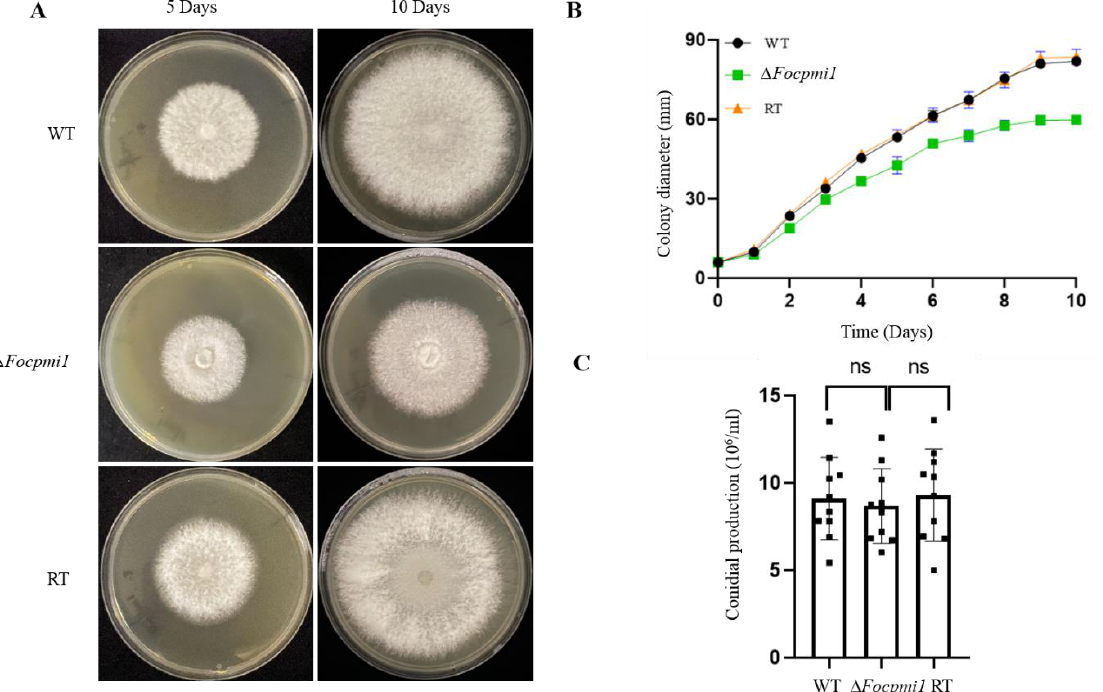
Figure 3. Vegetative growth of the WT, ∆ Focpmi1 , and RT strains on YPD supplemented with 5 mM mannose (YPDM). ( A ) Colony morphology of all the three strains. Freshly harvested conidia of the indicated strains were point inoculated onto YPDM plates and incubated at 28 °C for 5 and 10 days. ( B ) Colony diameter recorded for continuous 10 days after initial inoculation. ( C ) Conidia production of all the three strains. The data represents the mean ± SD from three independent experiments.